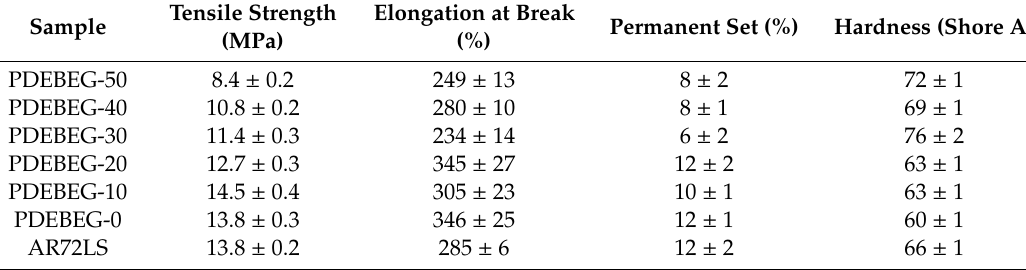
Table 6. Mechanical properties of the cross-linked PDEBEG / CB and AR72LS / CB elastomers.